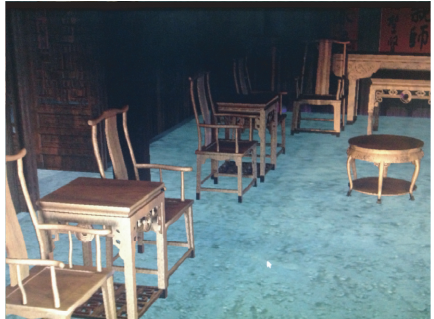
Figure 14: The camera will not advance if it touches a chair.